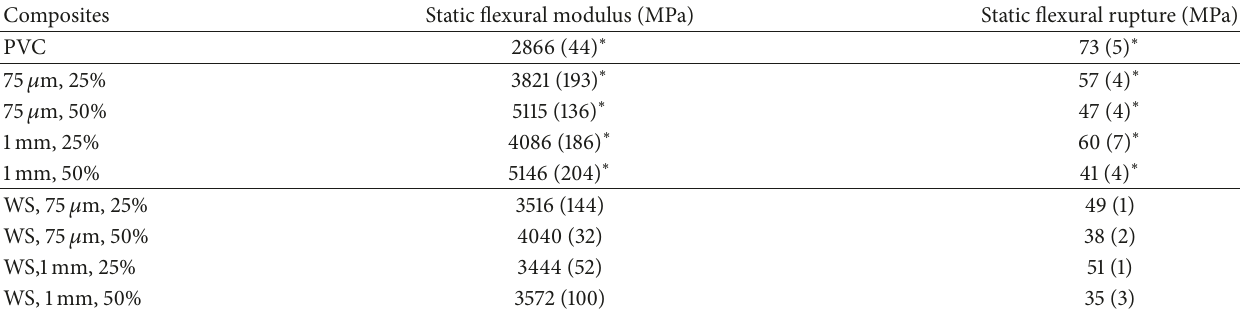
Table 2: A comparison between original and water-soaked composites in terms of static flexural properties (both from composition C 1 ). Composites